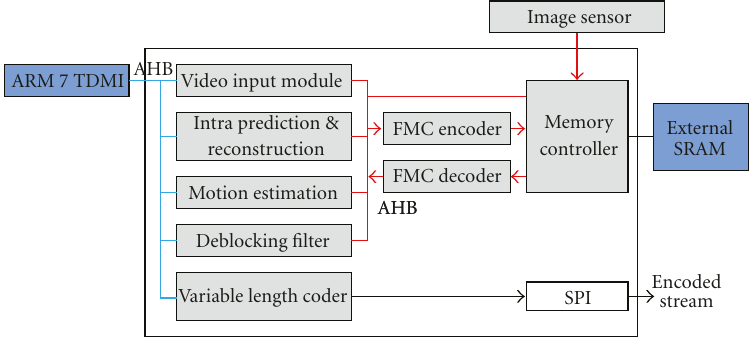
Figure 10: Block diagram of the H.264/AVC encoder integrated with the FMC encoder and decoder.